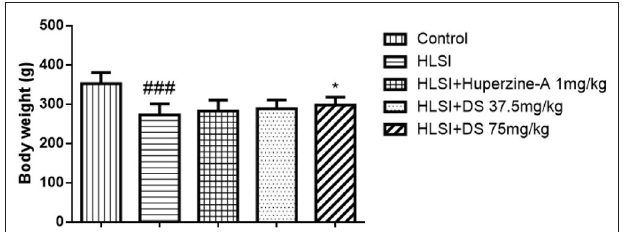
FIGURE 3 | The effects of DS on the body weight after HLSI in rats. All values are means ± SEM ( n = 8–10). The symbols represent: ### p < 0.0001 vs. the control group; * p < 0.05 vs. the HLSI group.